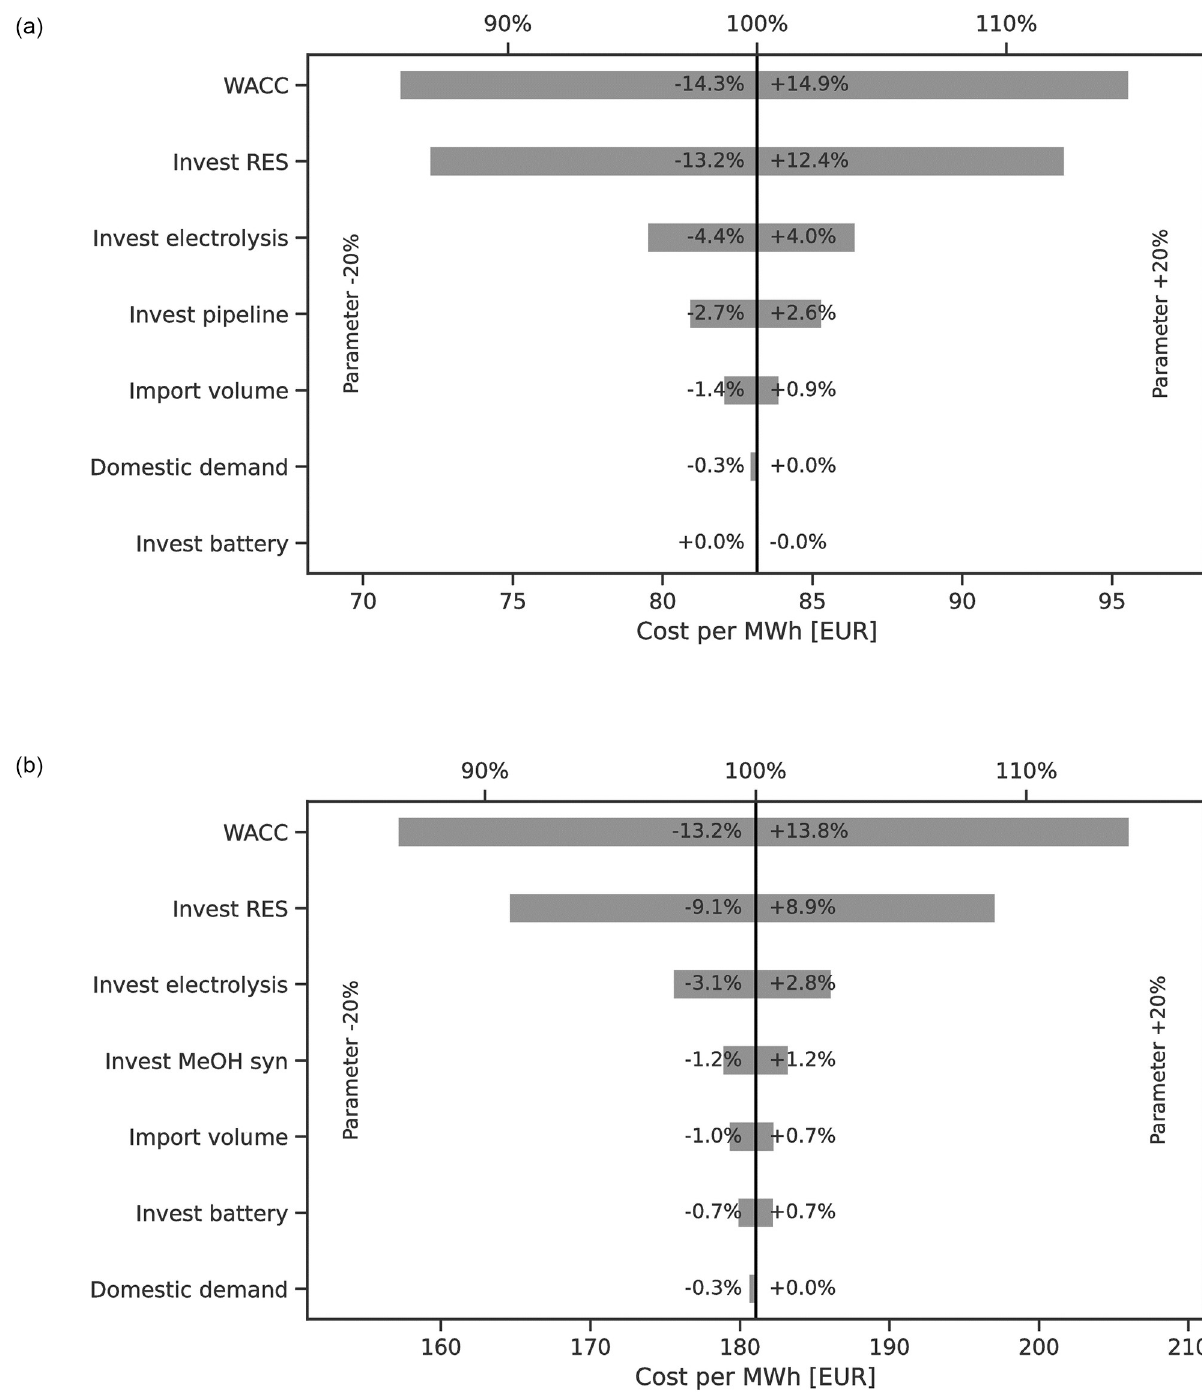
Fig 8. Sensitivities for two ESCs (left) H 2 (g) pipeline and (right) methanol by ship from ES to DE for 2030. Parameters listed on the left y-axis were varied by ± 20%. The x-axis shows the resulting LCoE after variation and the relative change. The highest impact on the LCoE can be attributed to the choice of WACC followed by the cost of renewables and hydrogen